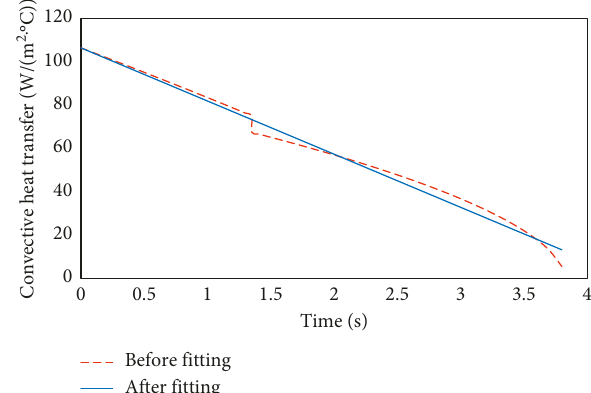
Figure 6: The relation curve of the convective heat transfer co- efficient and the braking time on the surface of the brake disc.